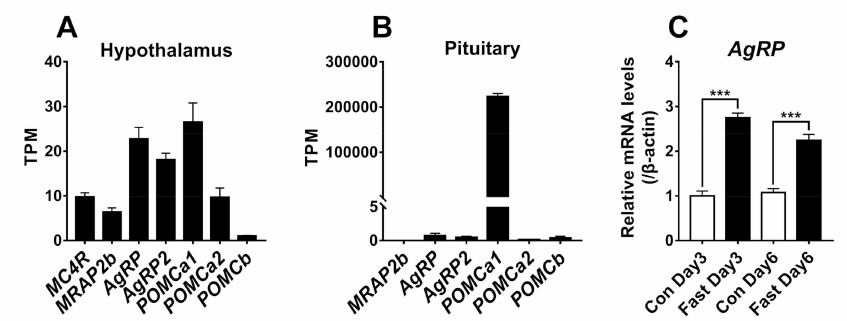
Figure 10. MC4R , MRAP2b , AgRP , AgRP2 , POMCa1 , POMCa2, and POMCb expression in tilapia hypothalamus and pituitary tissues. ( A ) The expression levels of MC4R , MRAP2b , AgRP , AgRP2 , POMCa1 , POMCa2, and POMCb mRNA were estimated using the RNA-Seq data from the hypothalamus of growing tilapia (30-day-old, n = 5). RNA-seq data were calculated as TPM (transcript per million). ( B ) The expression levels of MRAP2b , AgRP , AgRP2 , POMCa1 , POMCa2, and POMCb in the pituitary were estimated using the RNA-Seq data from the pituitary of 30-day-old tilapia ( n = 2). ( C ) Quantitative real-time RT-PCR assay of AgRP expression in the hypothalamus of 30-day-old tilapia under 3-day (Fast day3) or 6-day fasting (Fast day6) compared with that of control (Con day3, Con day6) (i.e., tilapia with free access to food). White pillars and black pillars indicated the control group and fasting group, respectively. Each data point represents the mean ± SEM of four tilapia ( n = 4). ***, p < 0.001 vs. control